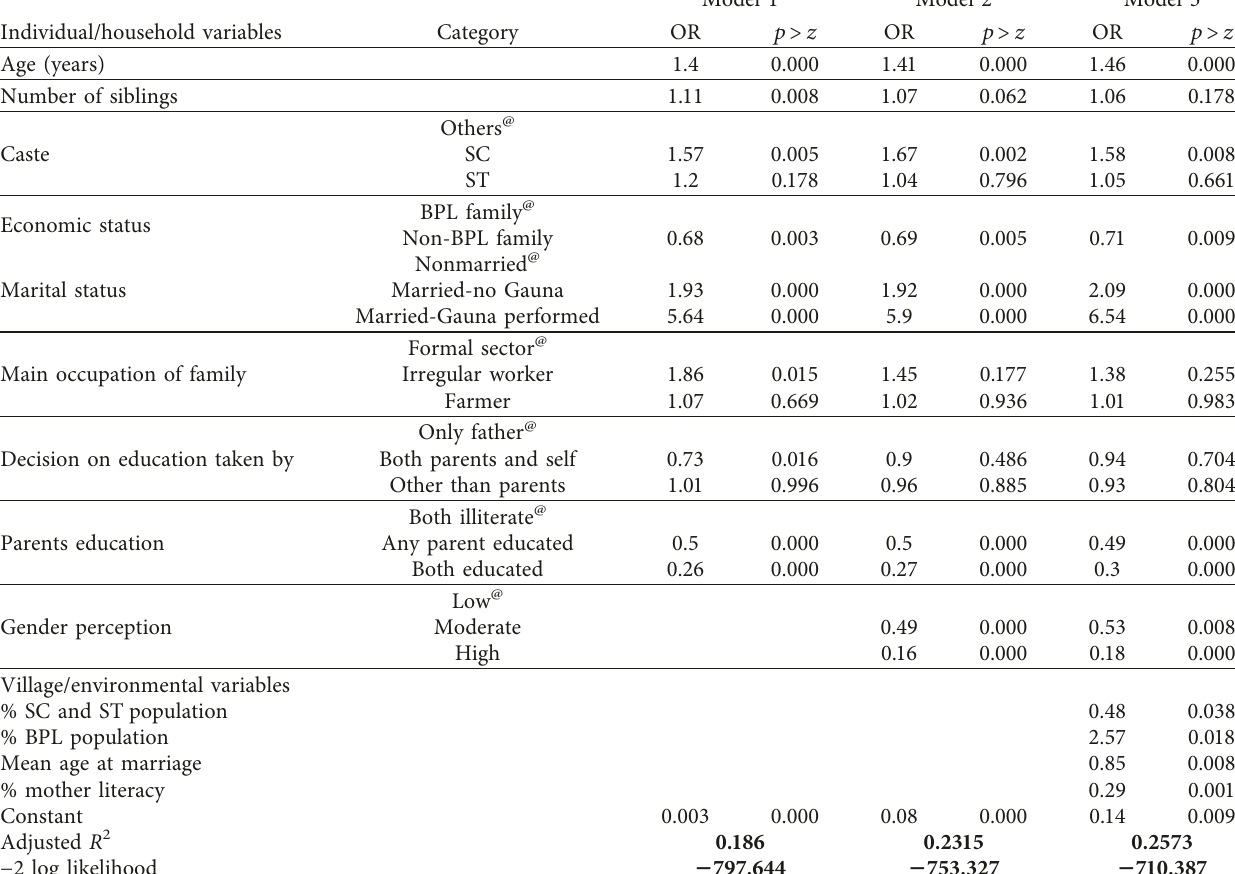
Table 3: Odds ratio (OR) of school dropouts by selected individual- and community-level